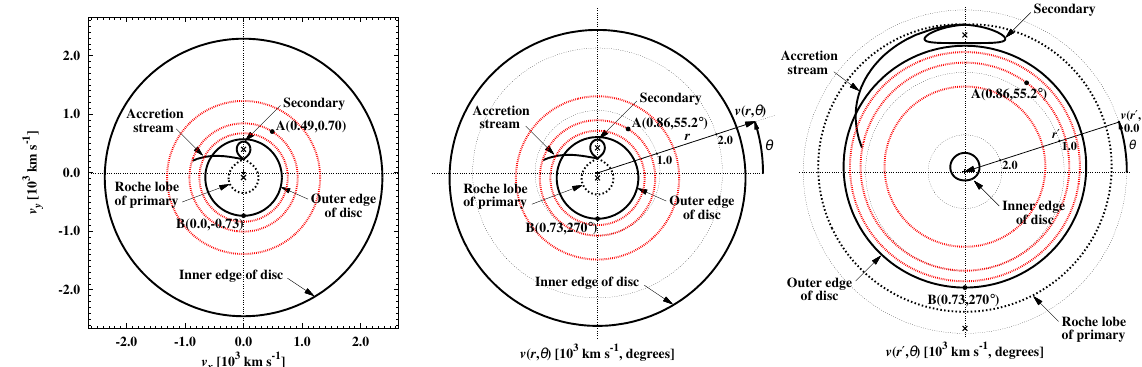
Figure 2: Cartesian (left), polar (middle) and inside-out polar (right) velocity